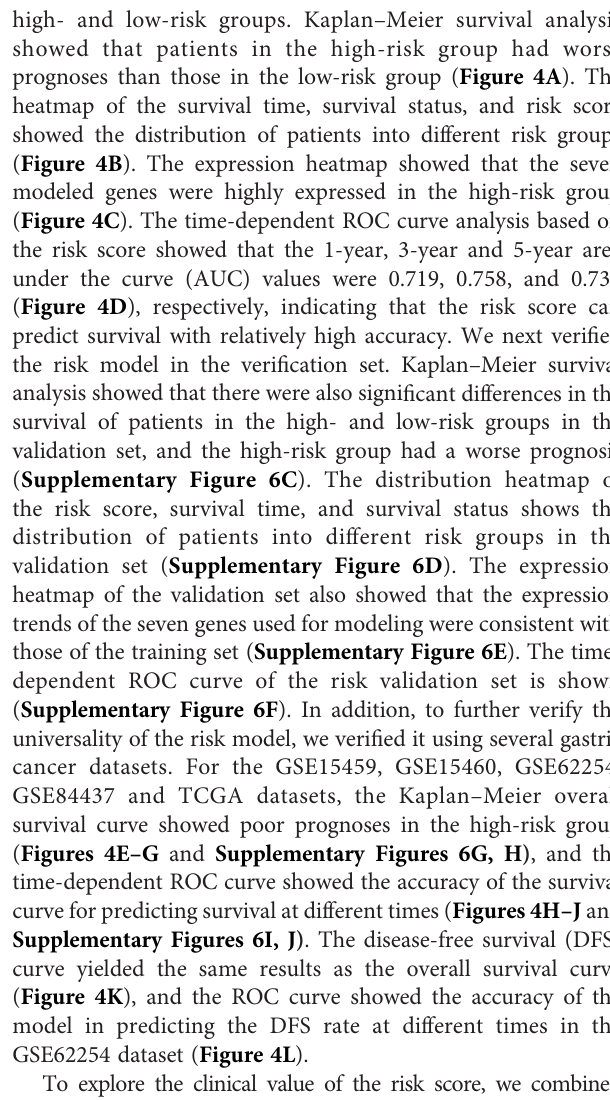
FIGURE 3 | Assessment of the differences in clinical characteristics and immune components between the two subtypes. (A) Kaplan – Meier survival analysis of the two clusters (cluster 1 n = 132, cluster 2 n = 116; log-rank test). (B) Analysis of the differences in clinical characteristics between the two clusters (cluster 1 n = 132, cluster 2 n = 116; categorical variables, chi-square tests; continuous variable, Student ’ s t-tests). (C) Identi fi cation of the differences in the tumor microenvironment (TME) between the two clusters (cluster 1 n = 132, cluster 2 n = 116; Student ’ s t-tests). (D) Comparison of the difference in the number of immune cells between the two clusters (cluster 1 n = 132, cluster 2 n = 116; Wilcoxon tests). (E) Comparison of the expression levels of immune checkpoint molecules between the two clusters (cluster 1 n = 132, cluster 2 n = 116; Student ’ s t-tests). (F) Difference heatmap of GSVA-based HALLMARK enrichment analysis between the two clusters (false discovery rate (FDR) <0.05) (cluster 1 n = 132, cluster 2 n = 116; Student ’ s t-tests). (G) Difference heatmap of GSVA-based KEGG enrichment analysis between the two clusters (FDR <0.05) (cluster 1 n = 132, cluster 2 n = 116; Student ’ s t-tests). All data are from the GSE15460 dataset. Signi fi cant difference between the two groups: *P < 0.05; ***P